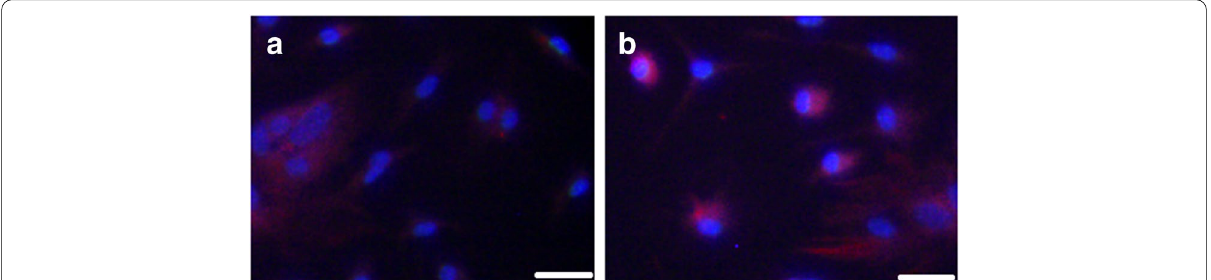
Fig. 5 Immunoflourcent staining of differentiated cells seeded on scaffold. The differentiated cells were immunopositive to specific spermatogenic markers of DAZL ( a ) and PLZF( b ). scale bars, 100